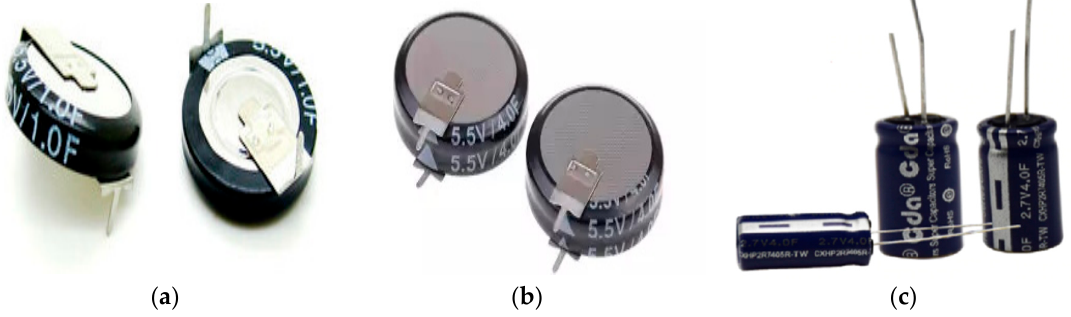
Figure 3. Type-A and -B button-shape super-capacitors ( a ) and ( b ) respectively and type-C cylindrical supercapacitors ( c ).